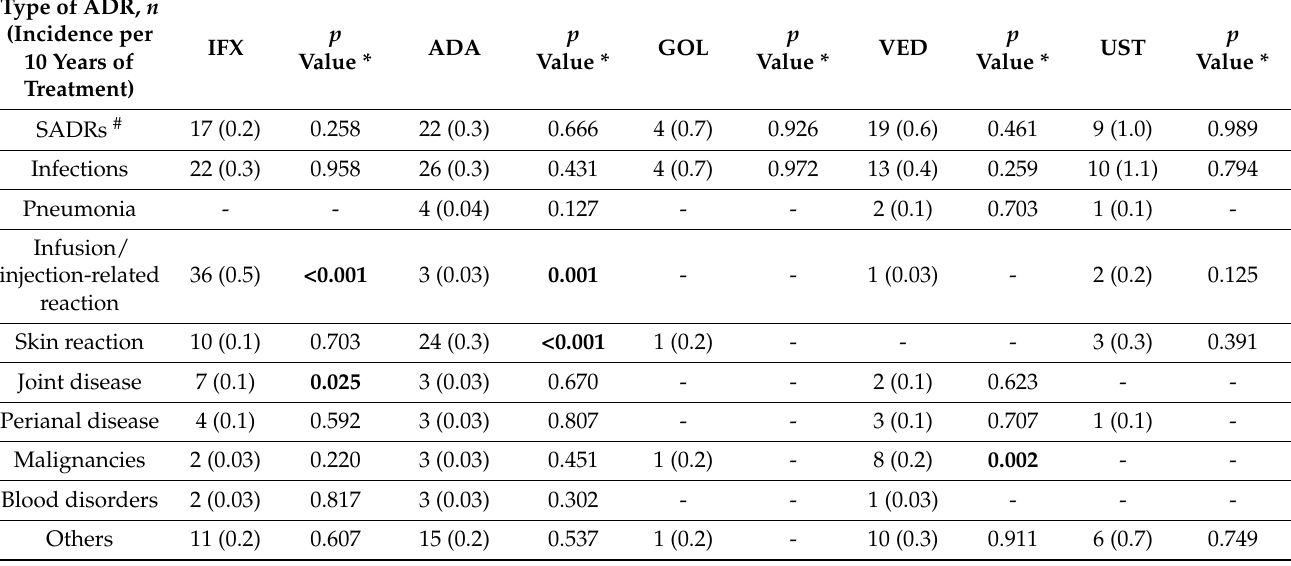
Table 5. Type of adverse drug reactions observed during the follow-up period for each